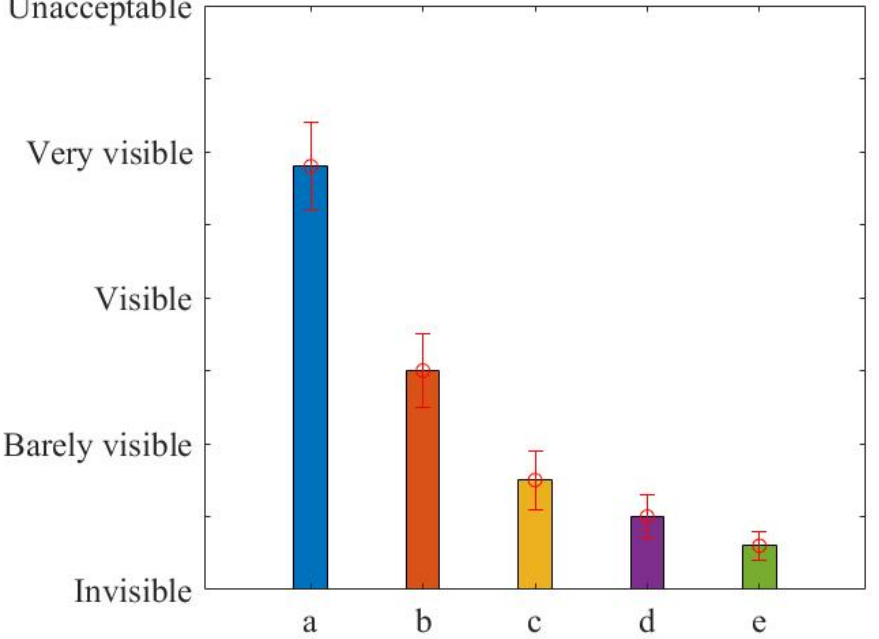
Figure 10. Qualitative analysis result of detail, showing the average ratings from the conducted experiment, with error bars for the standard errors. ( a ) KPN [3]. ( b ) CBDNet [24]. ( c ) SRNet [14]. ( d ) WCNN [13]. ( e ) Ours.